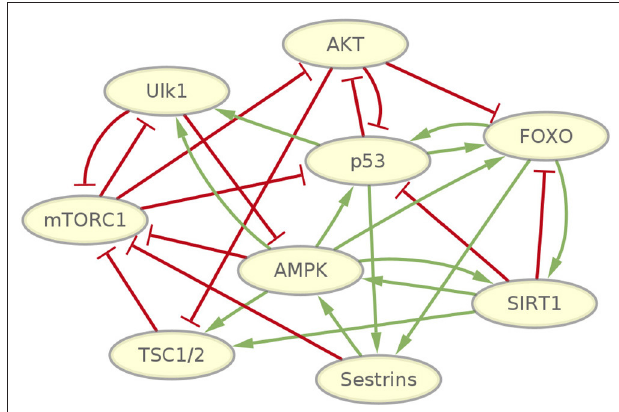
FIGURE 1 | Gene network wiring of mammalian cellular aging. Green arrows represent activation regulations. Red bars represent inhibition regulations.